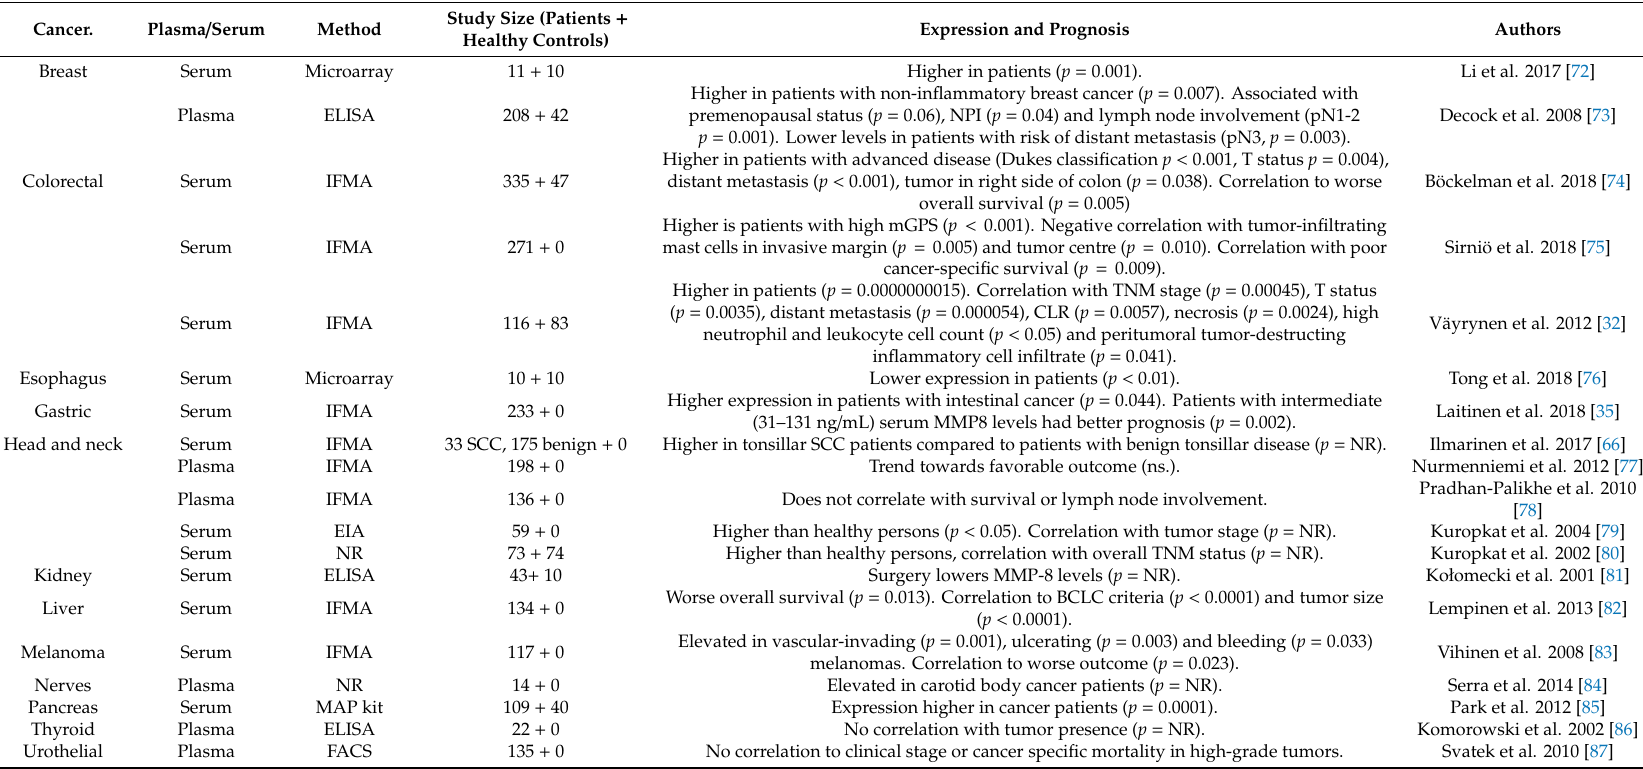
Table 2. Expression of matrix metalloproteinase 8 in blood and